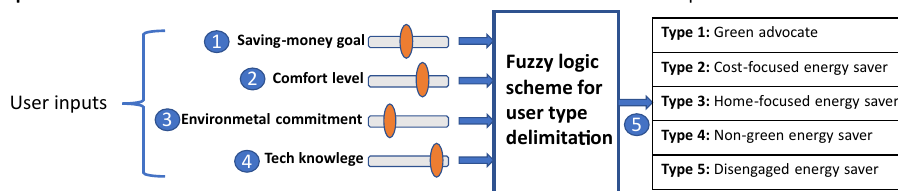
Figure 3. Diagram of Step